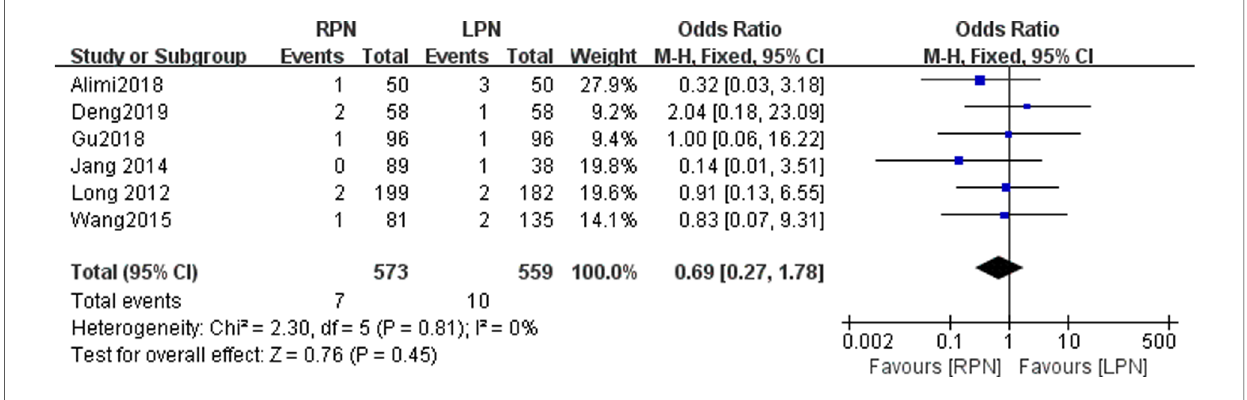
FIGURE 11 Forest plot for postive surgical margin between the RPN and LPN.